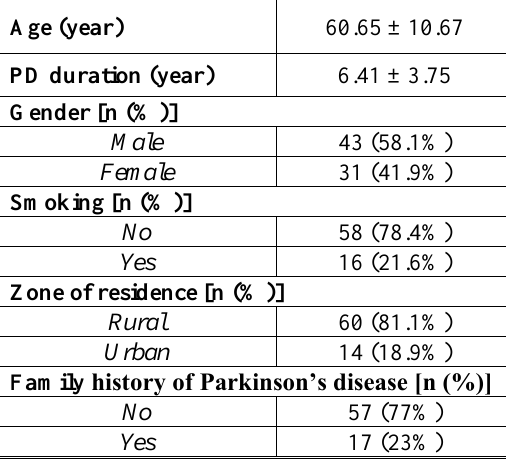
Table 2. Frequency and serum levels of anti T. gondii antibodies in Parkinson’s disease patients Serum anti-Toxoplasma IgG antibody